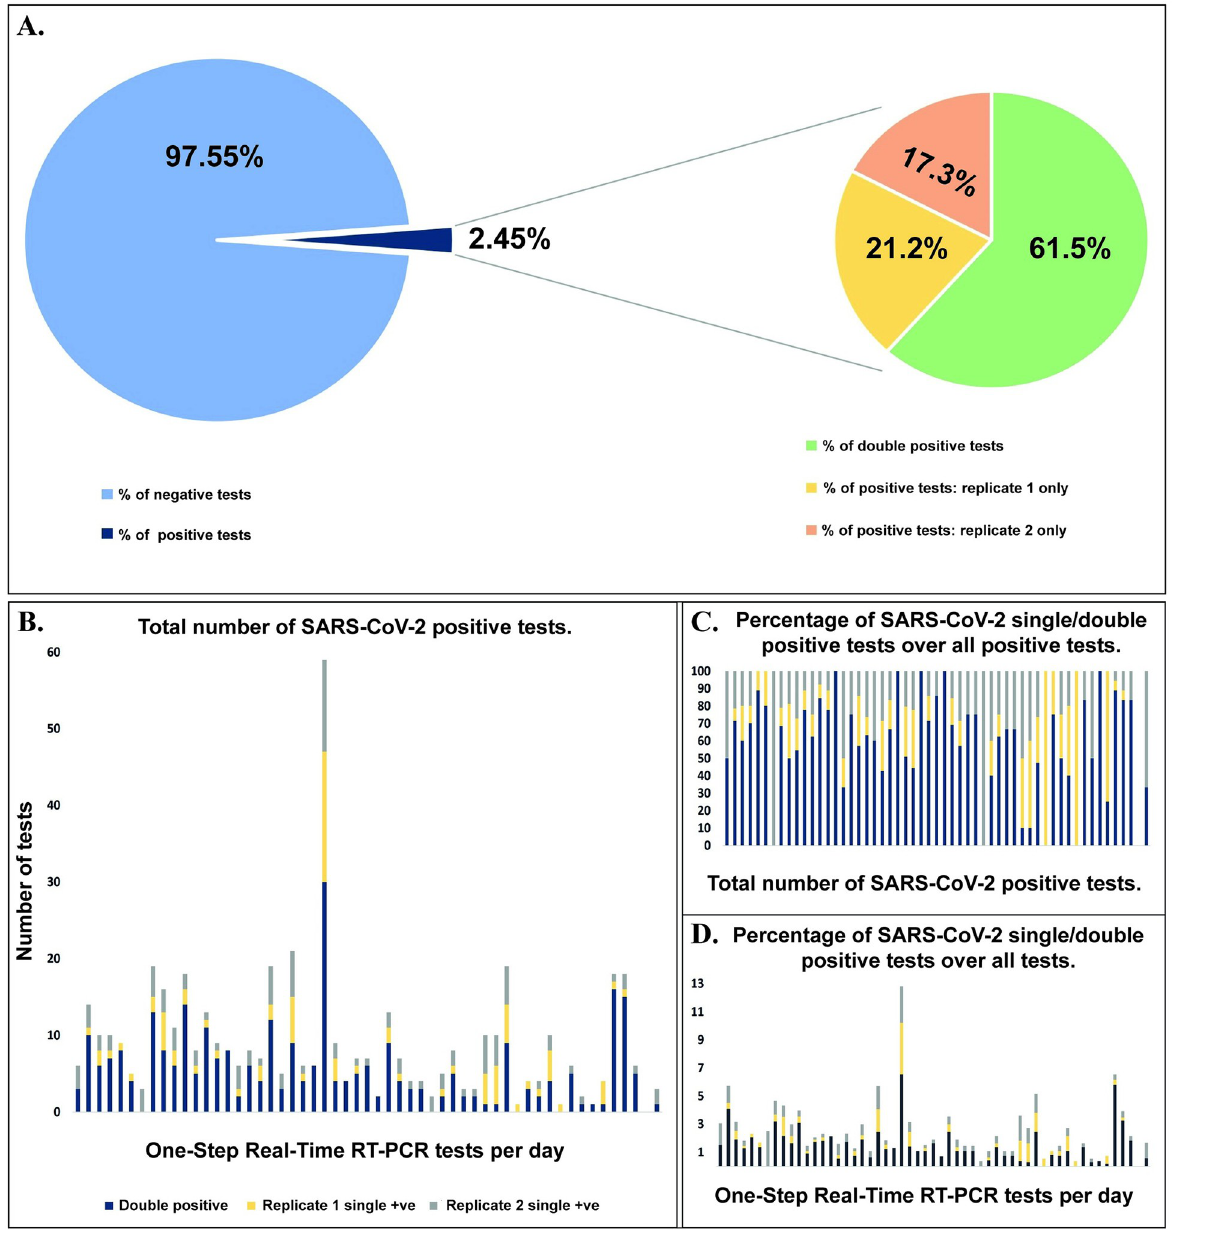
Fig 1. Graphic representation of the SARS-CoV-2 testing outcome of 10,014 nasopharyngeal swabs. (A) Graphic representation of SARS-CoV-2 positive sample reporting relative to Real-Time PCR reaction outcome. 491 patients or 2.45% tested positive for the SARS-CoV-2 virus. While 61.5% of SARS-CoV-2 infections were detected in both Real-Time PCR repeat testing reactions almost 40% of SARS-CoV-2 infections were detected in only one of the two repeat Real-Time PCR testing reactions. (B) Total number of patient nasopharyngeal swab tests detected positive for SARS-CoV-2 on duplicate, replicate 1 or replicate 2 Real-Time PCR. (C) Graphic representation of the percentage of duplicate, replicate 1 only and replicate 2 only Real- Time PCR confirmed SARS-CoV-2 positive samples over all positive detected samples. (D) Graphic representation of the percentage of duplicate, replicate 1 only and replicate 2 only Real-Time PCR confirmed SARS-CoV-2 positive samples over all tested samples.